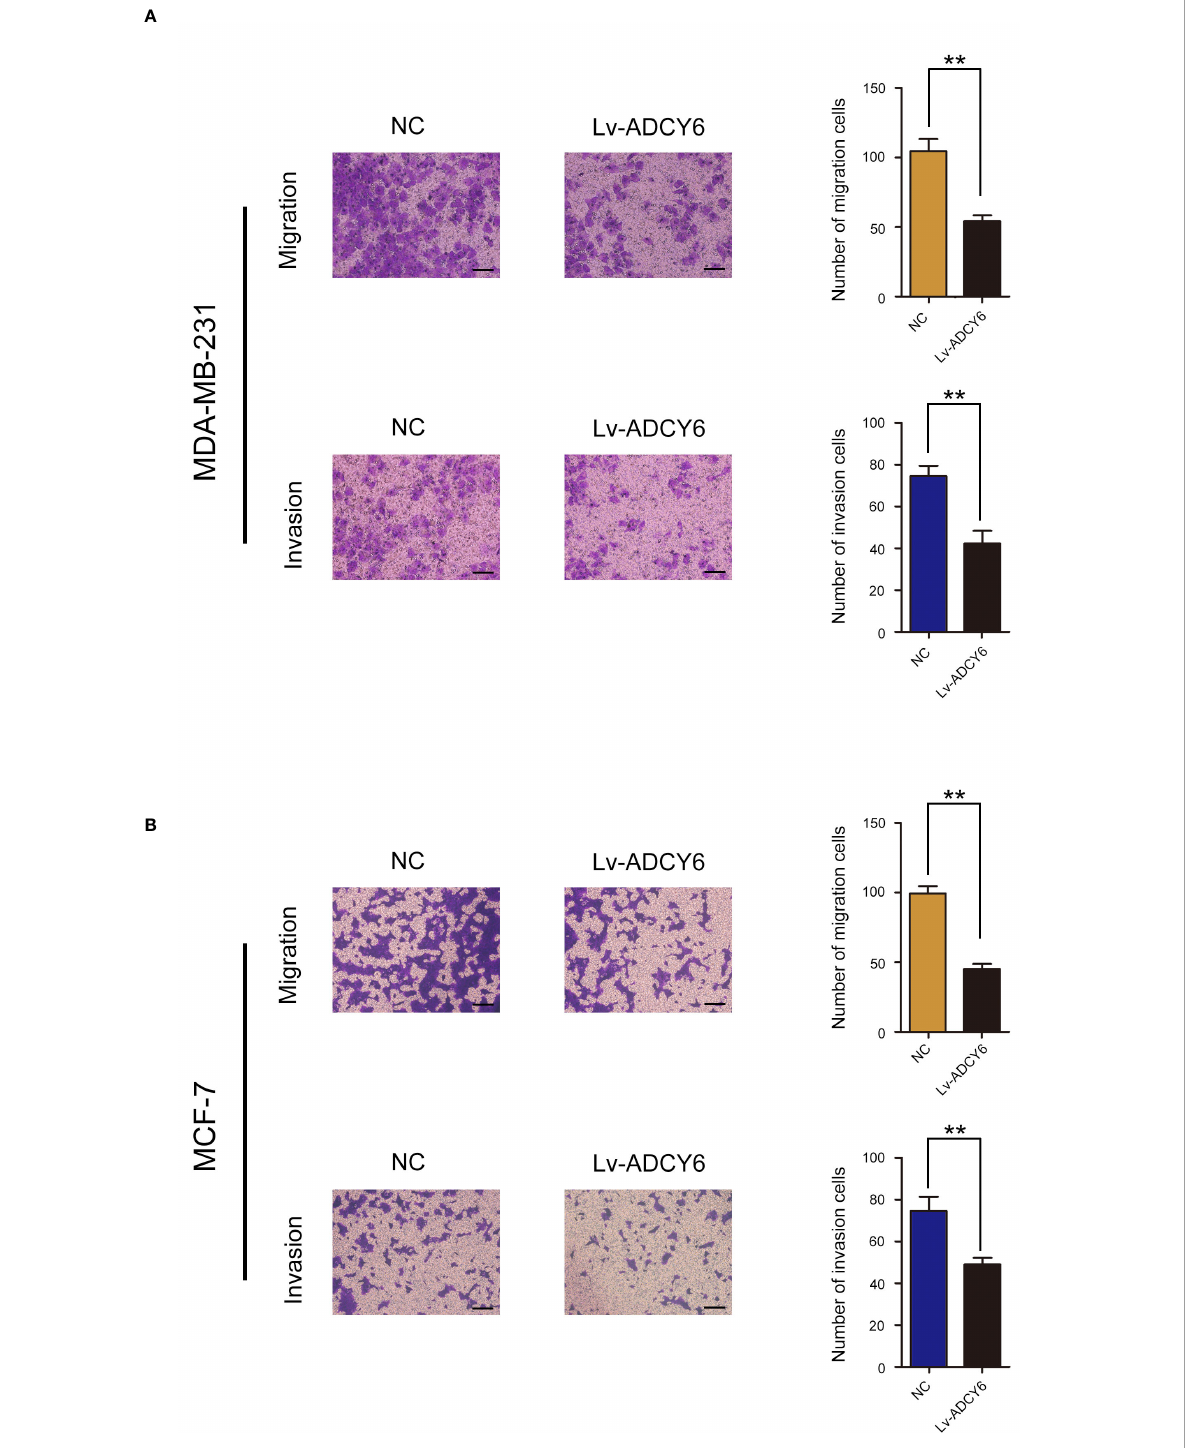
FIGURE 3 ADCY6 signi fi cantly suppressed the migration and invasion of breast cancer cell lines. (A) Transwell assay to detect MD-MBA-231 cell migration and invasion. Scale bars, 100 µm. **p < 0.01 versus controls. (B) Transwell assay to detect MCF-7 cell migration and invasion. Scale bars, 100 µm. **p < 0.01 versus